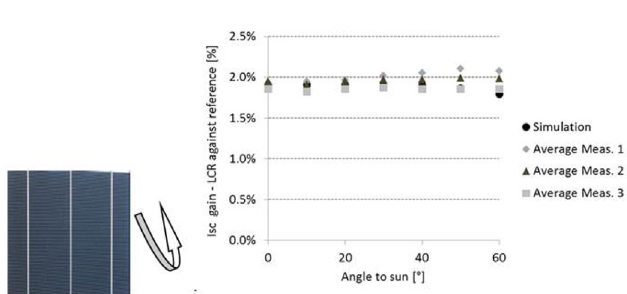
Fig. 10. Angle dependent gain of structured ribbons for ver- tical orientation of the ribbons.